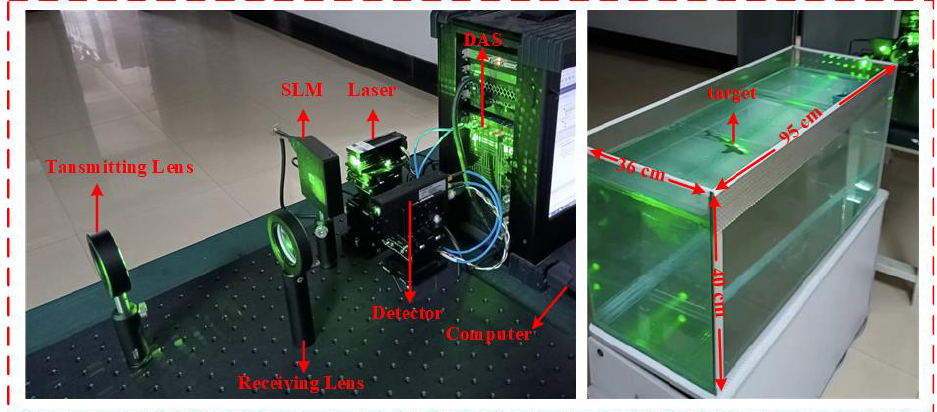
Figure 13. Experimental setup implemented in the lab.